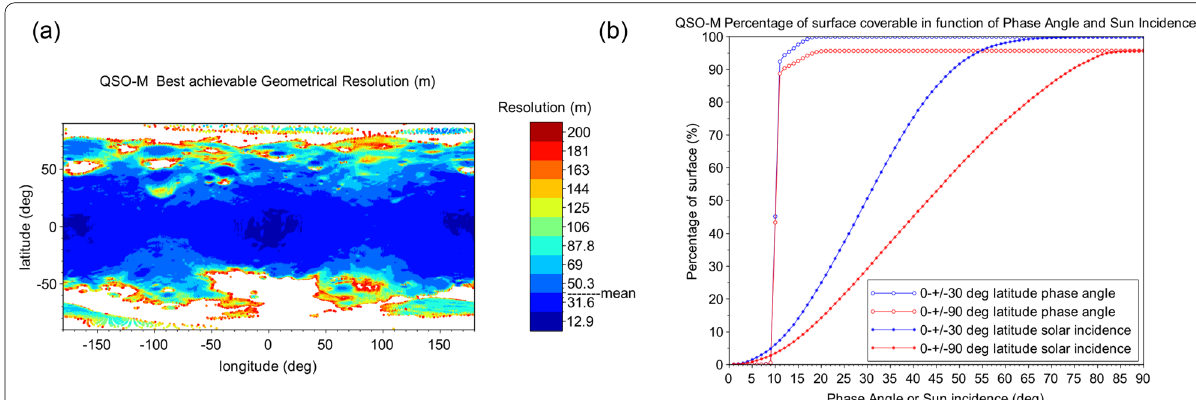
Fig. 7 a Coverage and geometric resolution of MIRS mapping from QSO‑M in Nov. 2025 ( β 3°). Areas in white cannot be observed because = of MMX equatorial trajectory and Phobos flat shape on the poles. Areas with resolution above 200 m are not displayed. Note that the map was calculated without considering the masking of facets by local topology. Percentage of surface covered at resolution better than 100 m is 99% for areas within 30° latitudes and 85% for all areas, at resolution better than 40 m is 94% for areas within 30° latitudes and 64% for all areas, at ± ± resolution better than 30 m is 78% for areas within 30° latitudes and 49% for all areas, at resolution better than 20 m is 38% for areas within 30° ± ± latitudes and 22% for all areas, and at resolution better than 10 m is 0% for areas within 30° latitudes and 0% for all areas. b Percentage of Phobos ± surface covered in function of phase and sun incidence angles by observation in